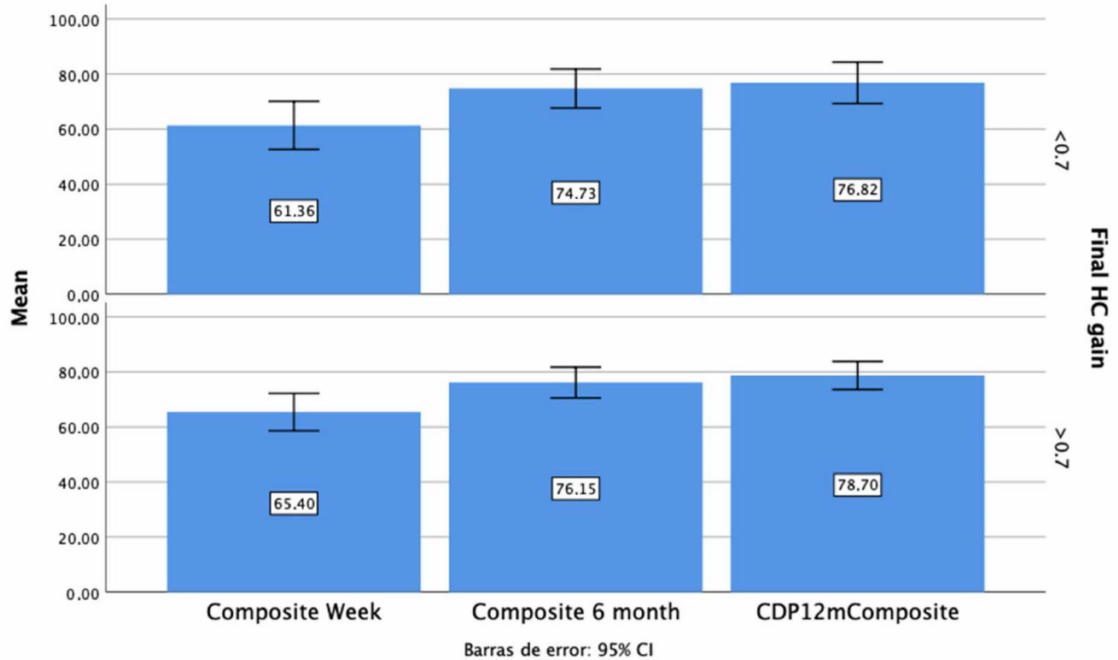
Figure 3. Composite score at every follow up, depending on the HC final